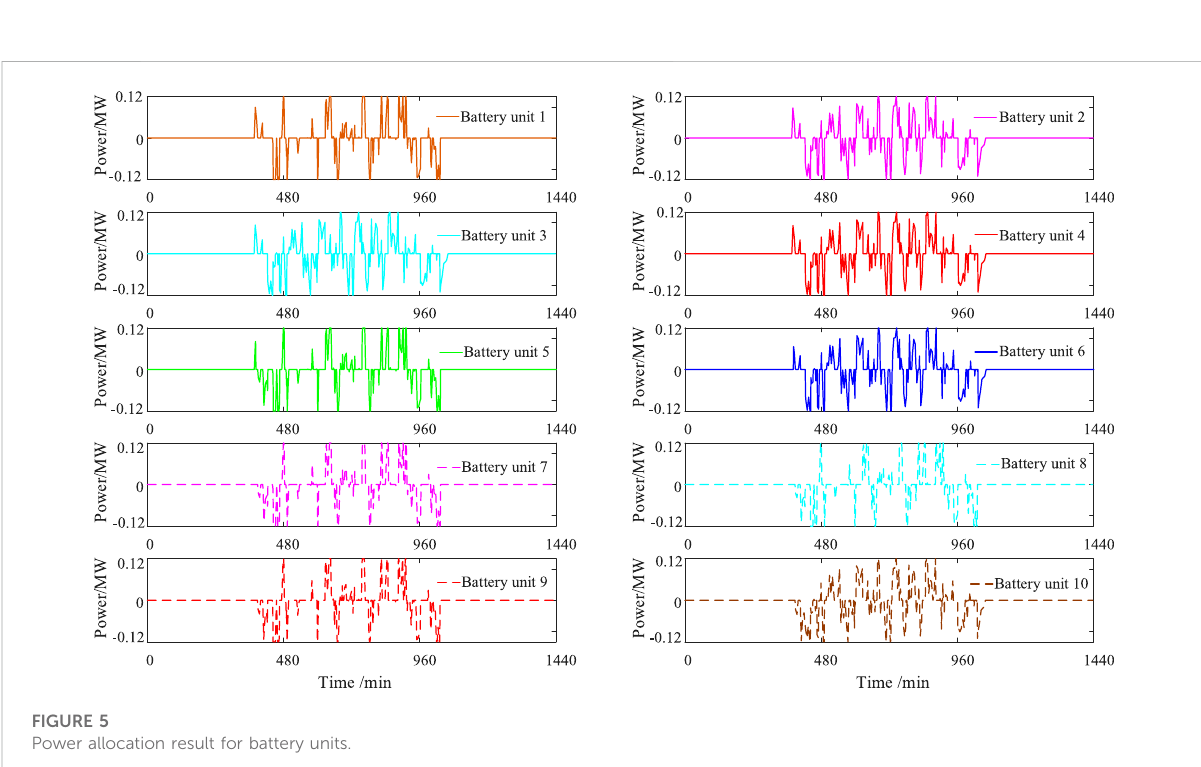
FIGURE 5 Power allocation result for battery units.